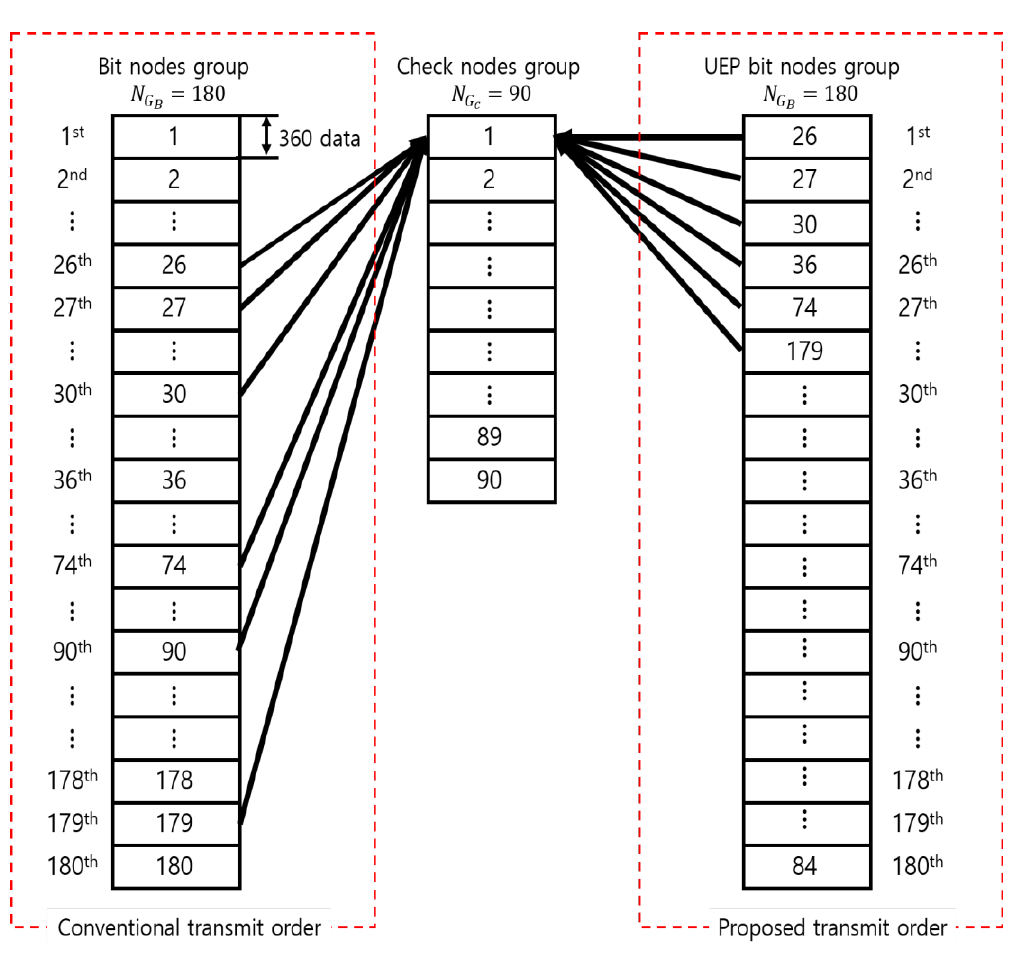
Figure 6. The order of the bit node group, with or without the UEP algorithm.